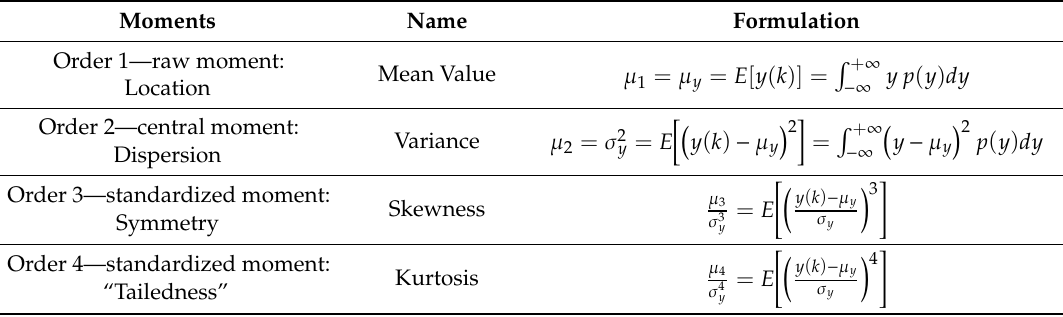
Table 1. The most widely used moments of a probability distribution